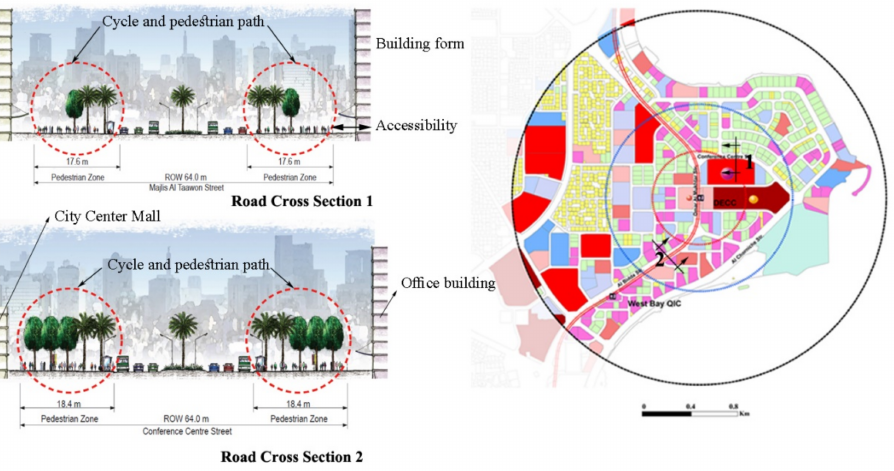
Figure 17. Street Network Cross section.